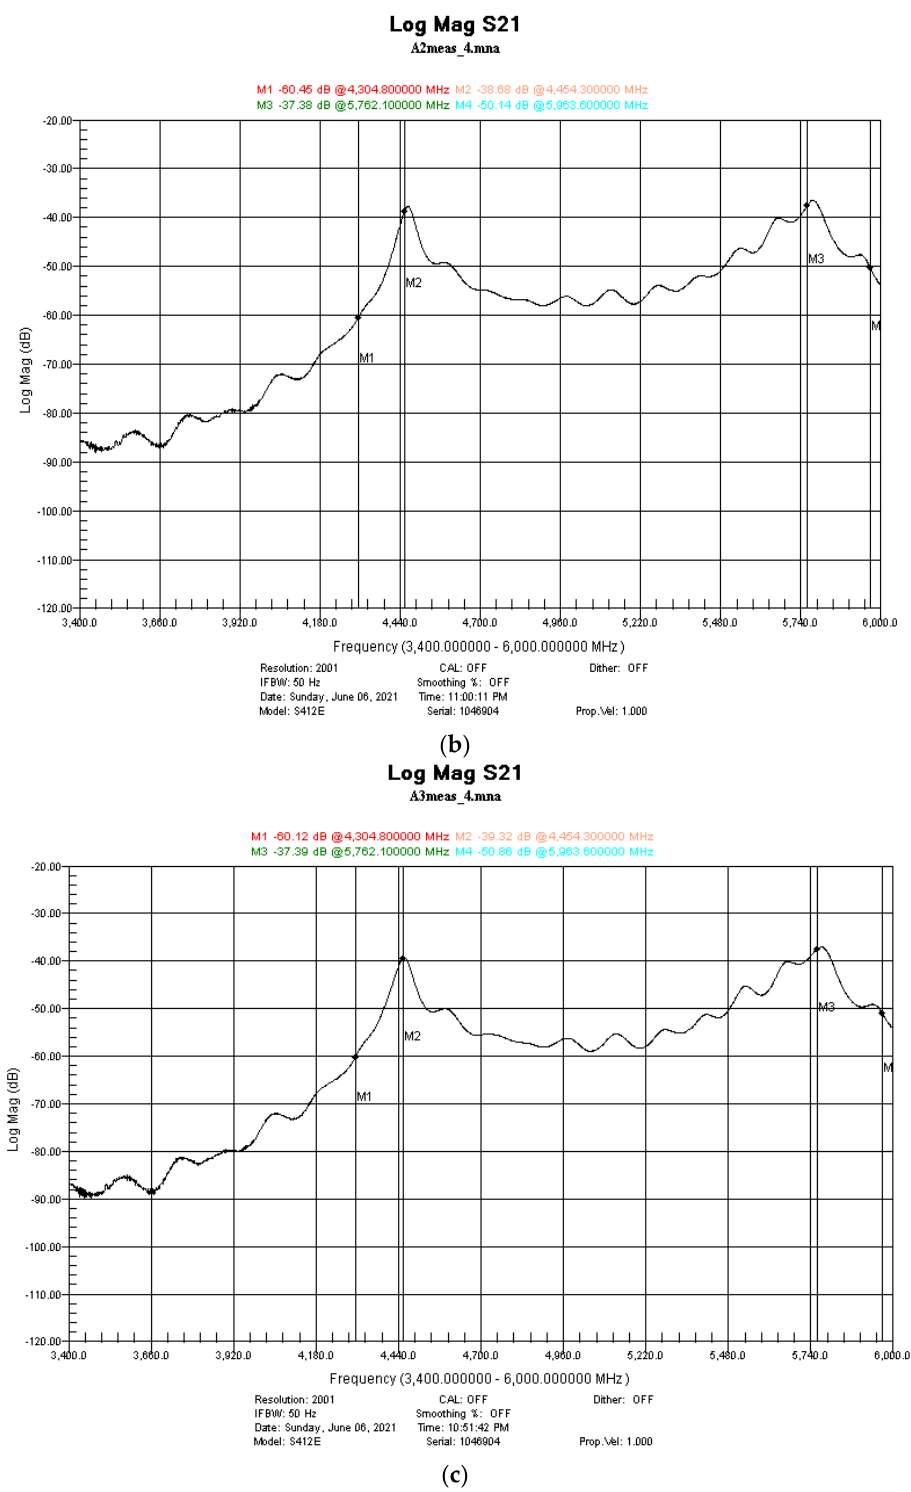
Figure 8. Examples of electromagnetic shielding effectivity of ( a ) one layer, ( b ) two layers, and ( c ) three layers of HCl-doped PANI/graphene/PEDOT:PSS water-based formulation with different numbers of applied layers.